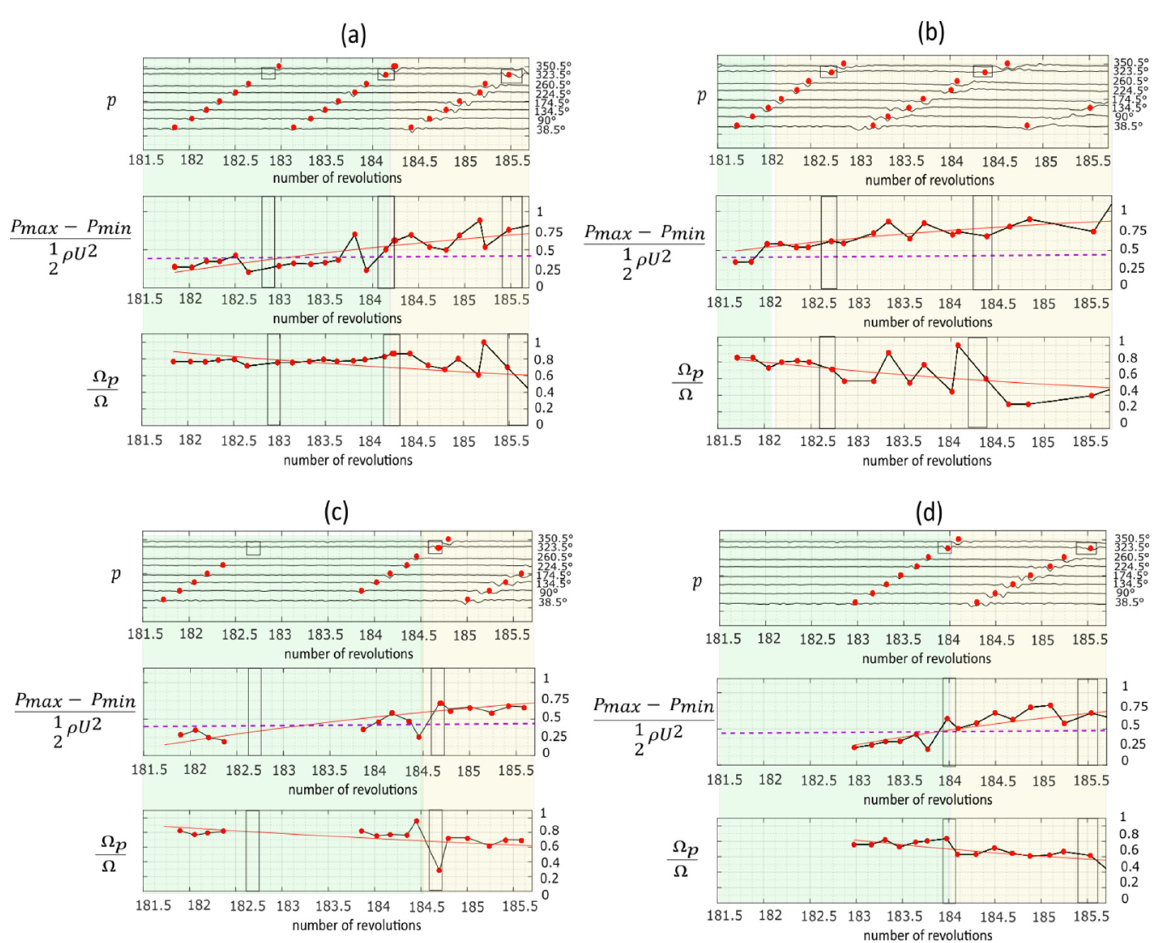
Figure 10. Four (a–d) repetitions of rotating stall transient with 60° grid. Black rectangles: position of the 60° grid. Dashed line in the bottom panel: threshold for spike development; red continuous line: polynomial fit, which appears also in Figures 8 and 9. Green background: part of the signal below threshold; yellow background: part of the signal above the threshold.